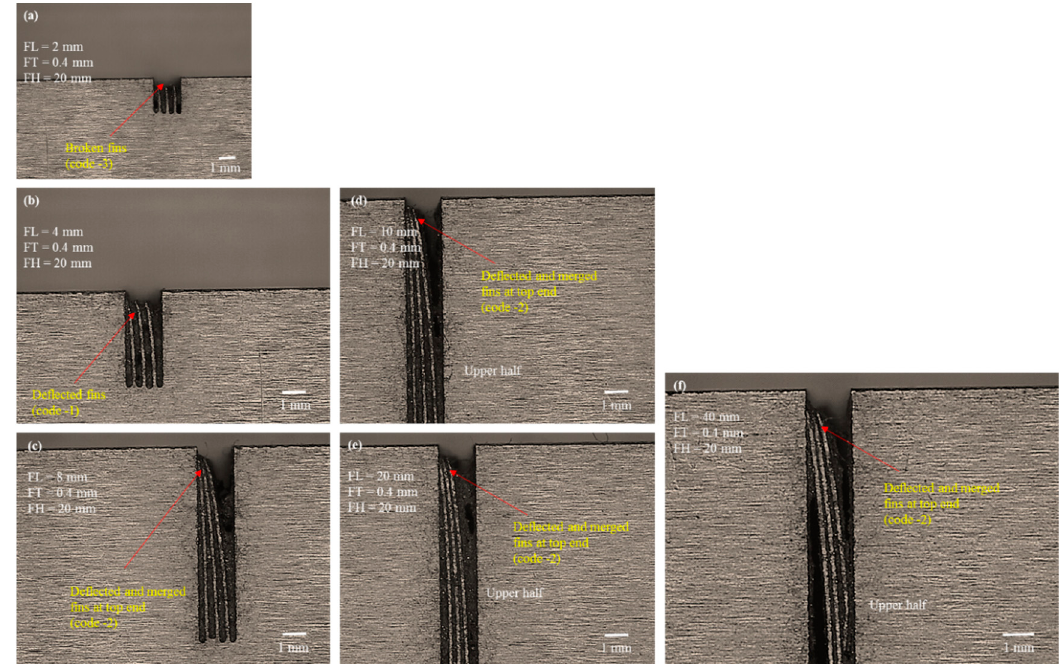
Figure 9. Microscopic analysis of structure traits under the second phase of experimentation with designed fin thickness (FT_d) of 0.4 mm and FH 20 mm: ( a ) FL 2 mm, ( b ) FL 4 mm, ( c ) FL 8 mm, ( d ) FL 10 mm upper half, ( e ) FL 20 mm upper half, and ( f ) FL 40 mm upper half.